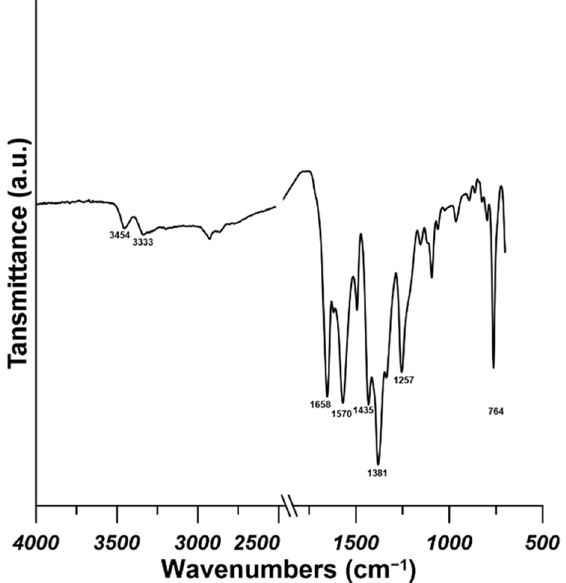
Materials 2021 , 14 , 3366